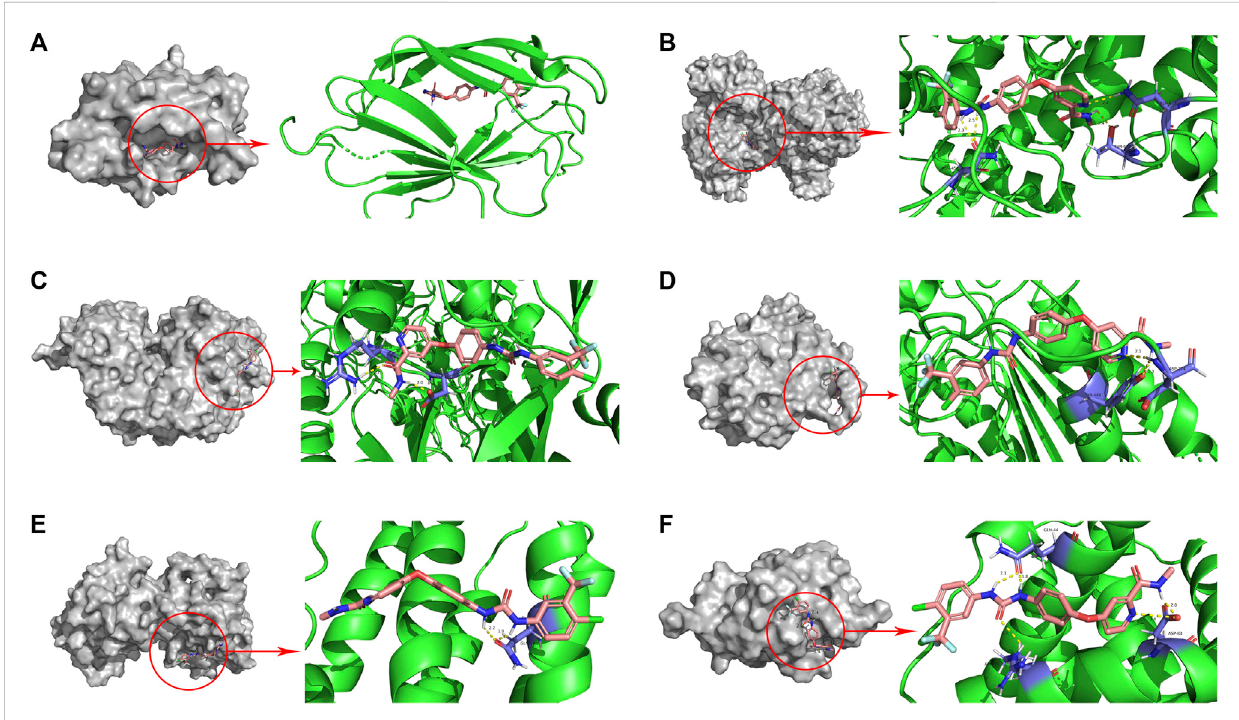
FIGURE 10 Molecular docking pattern of sorafenib and core target protein. [ (A) sorafenib-LY96, (B) sorafenib-PIK3CA, (C) sorafenib-NT5E, (D) sorafenib- CASP8, (E) sorafenib-IFNB1, (F)